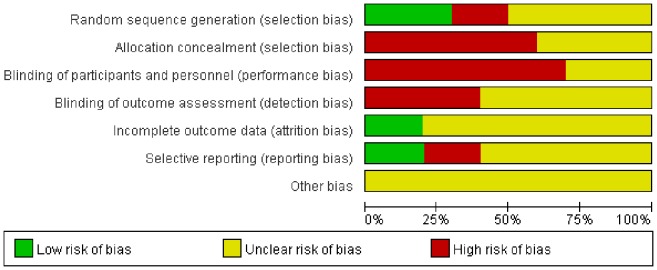
Risk of bias.Each risk of bias item is presented as the percentage across all the included studies, which indicates the proportion of different levels of risk of bias for each item.